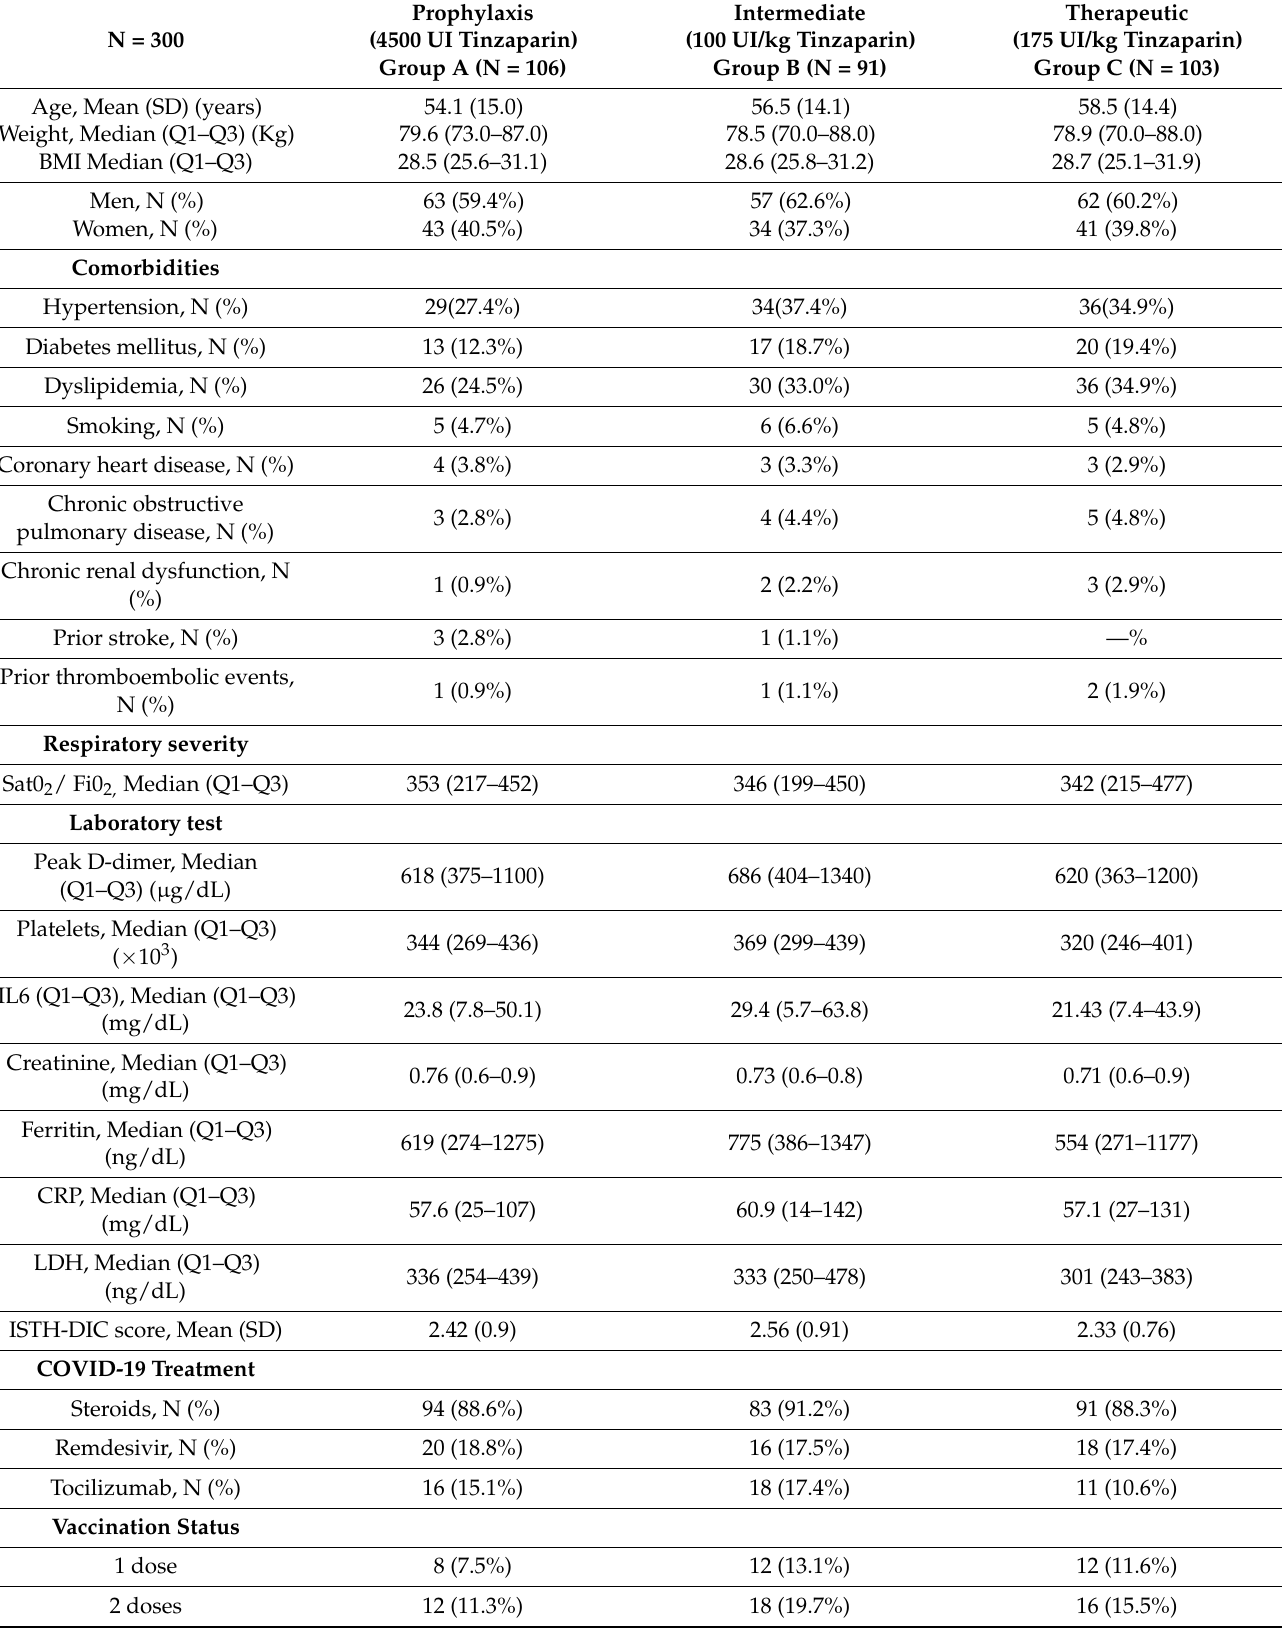
Table 1. Baseline characteristics of patients included in PROTHROMCOVID